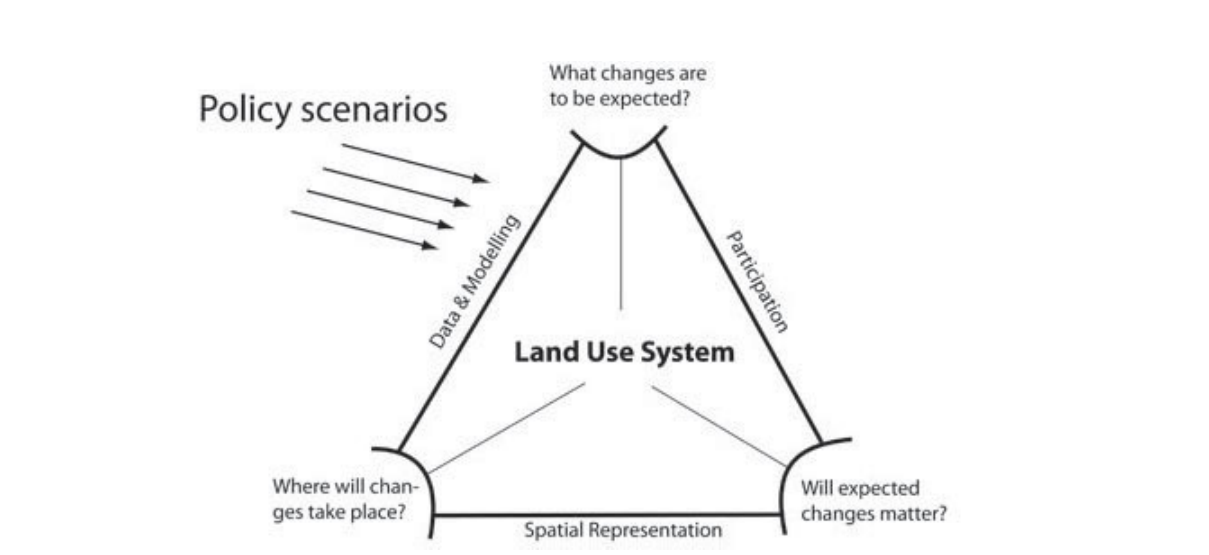
Fig. 1. Three consecutive questions to be addressed for impact assessment of land use